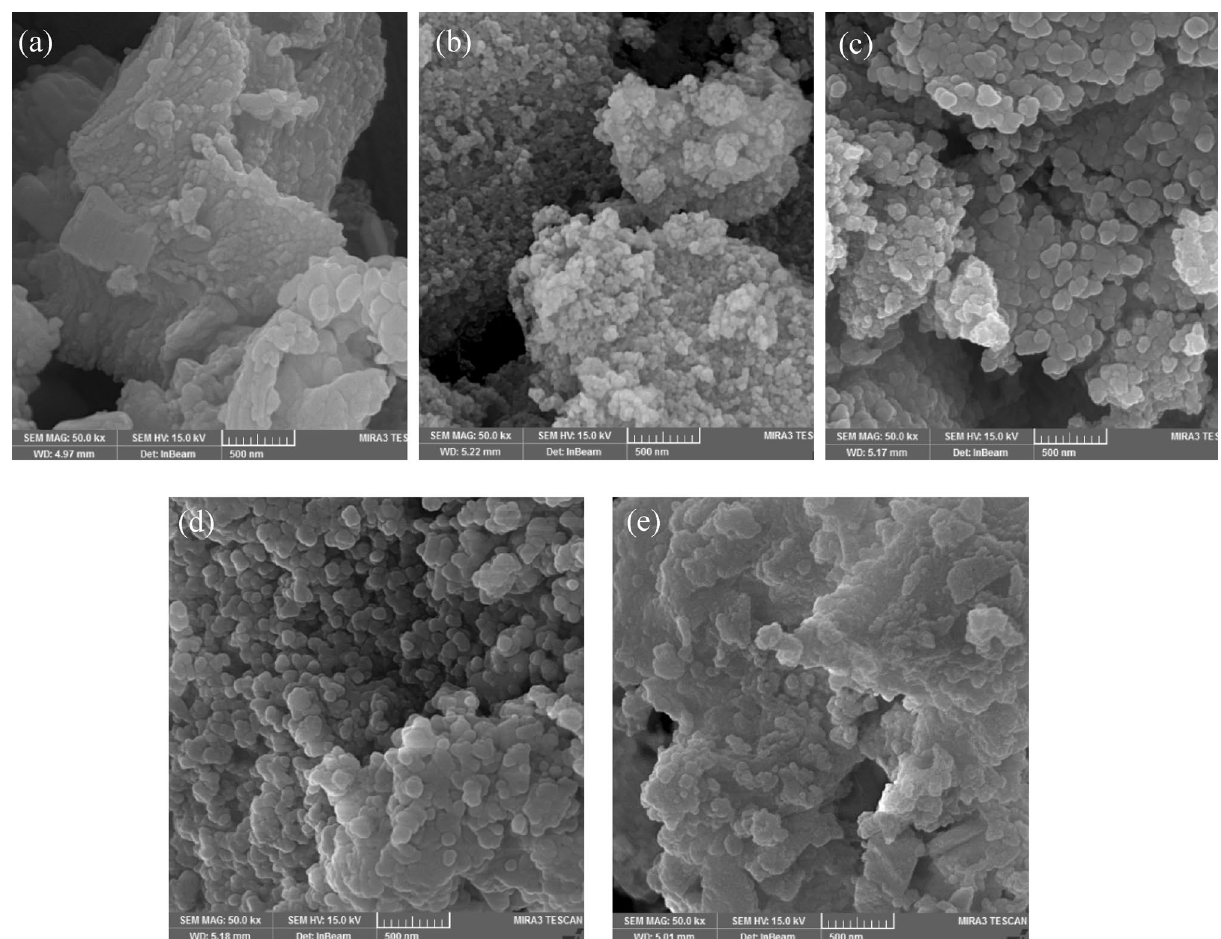
Figure 1. FESEM images of ( a ) talc ( b ) Talc-nZVI/1Sn ( c ) Talc-nZVI/4Sn ( d ) Talc-nZVI/6Sn ( e ) Talc- nZVI/6Sn after reaction with